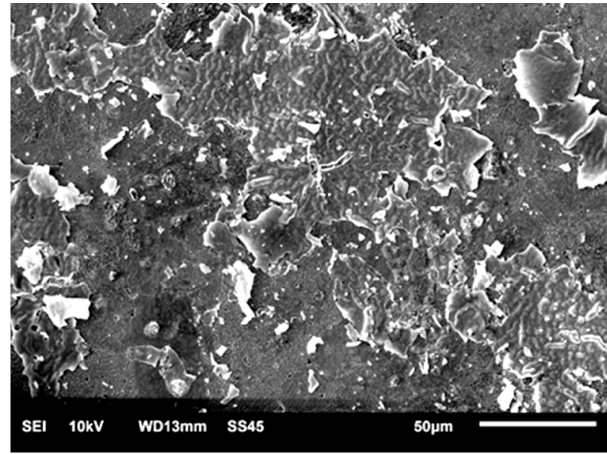
Figure 5. SEM-SE surface morphology of SM-HT (×500).